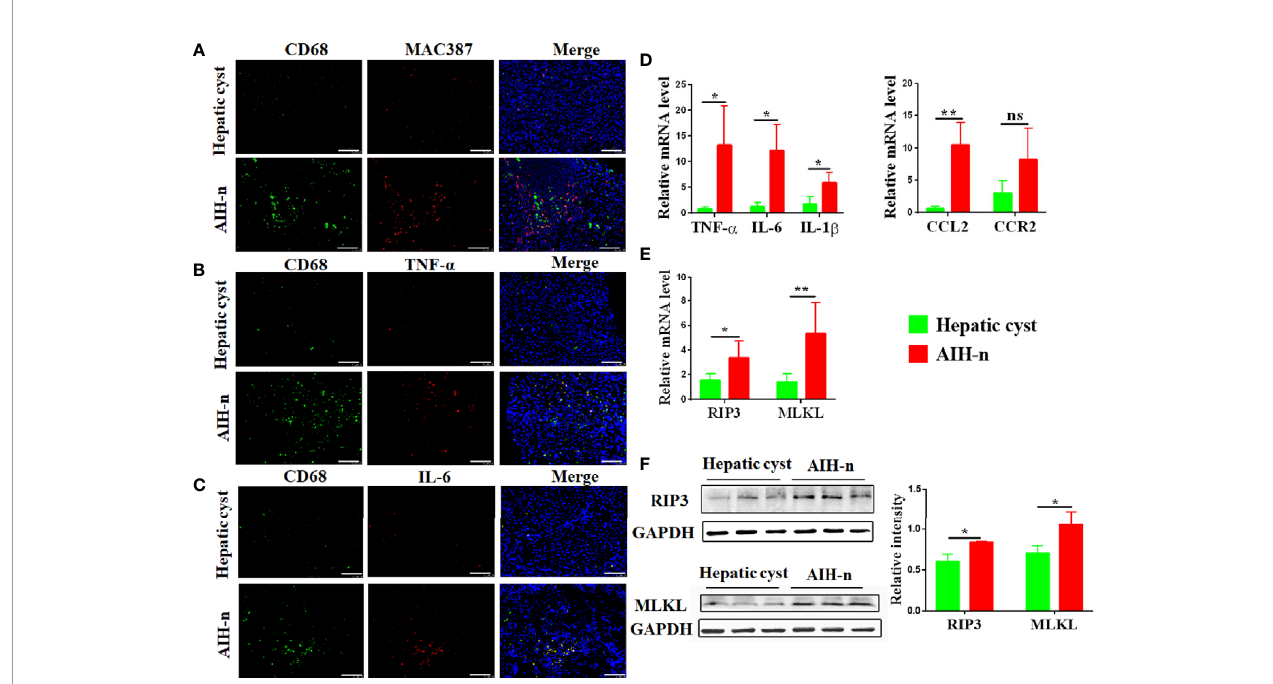
FIGURE 2 | Activation and in fi ltrating of macrophages in the liver tissue of AIH patients. (A – C) Double-immuno fl uorescence staining for CD68 and MAC387 (A) CD68 and TNF- a (B) CD68 and IL-6 (C) in liver tissues of patients with AIH and hepatic cyst. (D) RT-qPCR analysis of TNF- a , IL-6, IL-1 b , CCL2 and CCR2 on tissue homogenates from the liver of the two groups. (E) RT-qPCR analysis of RIP3 and MLKL in the liver of the two groups. (F) Protein levels of RIP3 and MLKL in the liver of the two groups were detected and the relative intensity was quanti fi ed. Scale bars: 100 m m. The data were presented as means ± SD (Student ’ s t-test, *p < 0.05, **p < 0.01, ns: p <